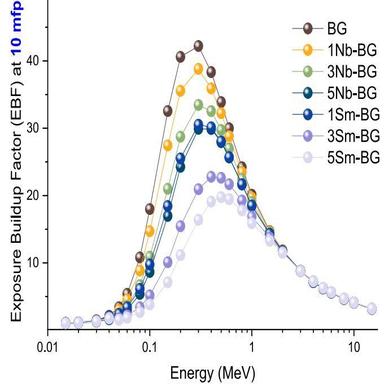
Comparison of exposure buildup factor (EBF) values at 10 mean free path (mfp).